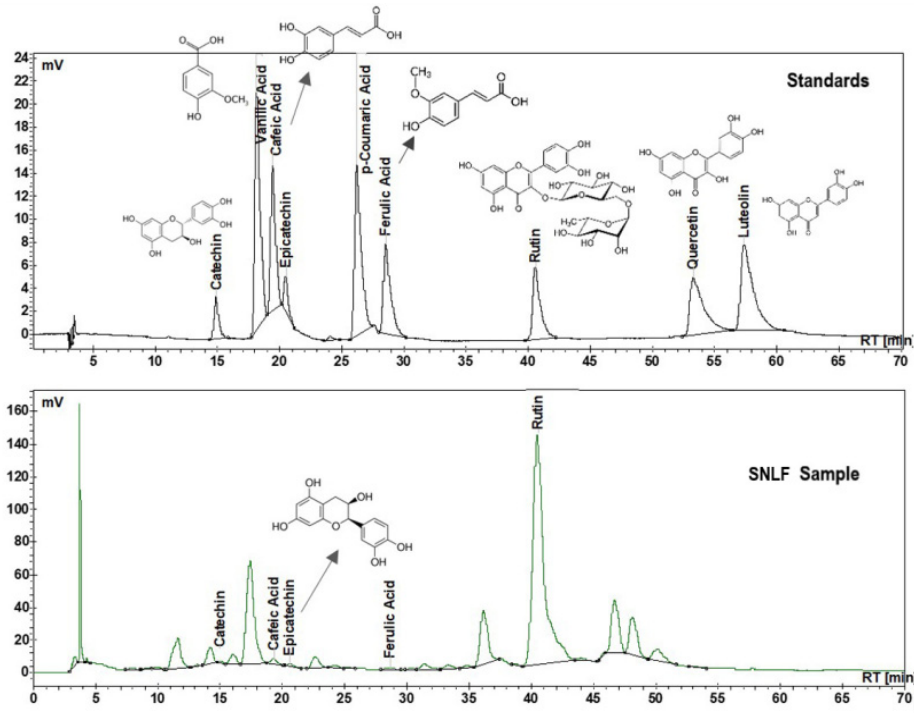
Figure 2. HPLC-UV chromatograms of standards mixture of studied phenolic compounds and analyzed SN ethanolic extract.